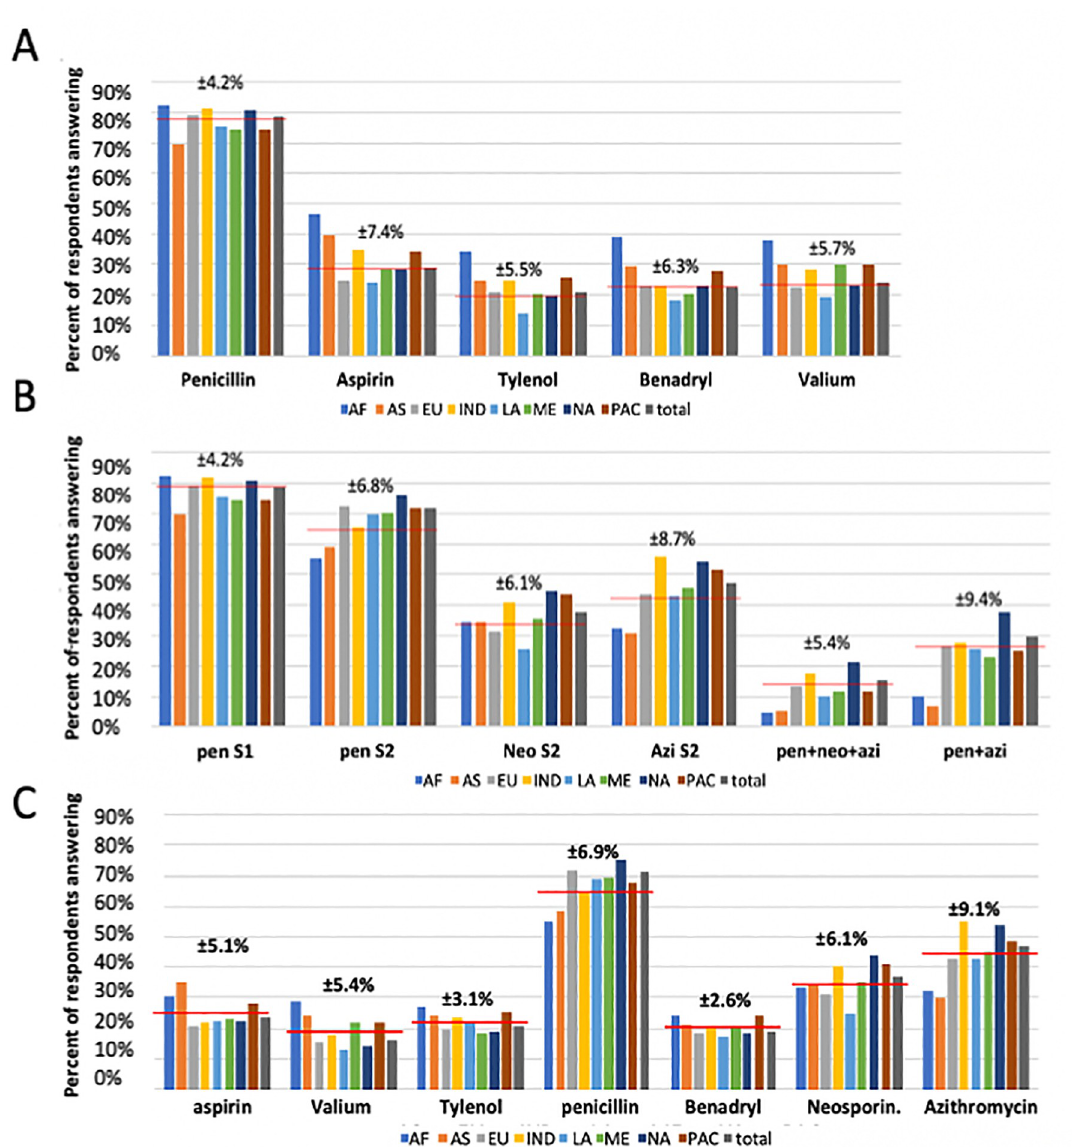
Fig 2. Ability to identify antibiotics. (A). The distribution of the indicated responses for Survey 1/Question 3. (B) The distribution of the indicated answers for Survey 2/Question 5 Both figures show the distribution by general geographic region. Geographic regions are Africa [AF], Asia [AS]. Europe [EU], India [IN], Latin and South America [LA], Middle East [ME], North America [NA] and Pacific Region [PAC]). PenS1 and PenS2 indicate the proportion of answers that identified penicillin as an antibiotic in Survey 1 and Survey 2 respectively. NeoS2 and AziS2 indicate identification in Survey 2 of Neosporin and Azithromycin as antibiotics. pen+neo+azi indicates the percent of answers that correctly identified penicillin, Neosporin and Azithromycin as antibiotics. Pen + Azi indicates the percent of answers that correctly identified penicillin and Azithromycin, as antibiotics. For each panel, the horizontal red lines indicate the overall average and the standard deviation is also shown above the bars. (C) Histograms summarizing percent of respondents answering the individual choices to “Which of the following are antibiotics?” for each of the possible choices. See https://sepakiosk.com/ for raw data. Abbreviations: NA = North America, ME = Middle East, LA = Latin America, IND = India, EU = Europe, AS = Asia, AF = Africa, PAC = Pacific